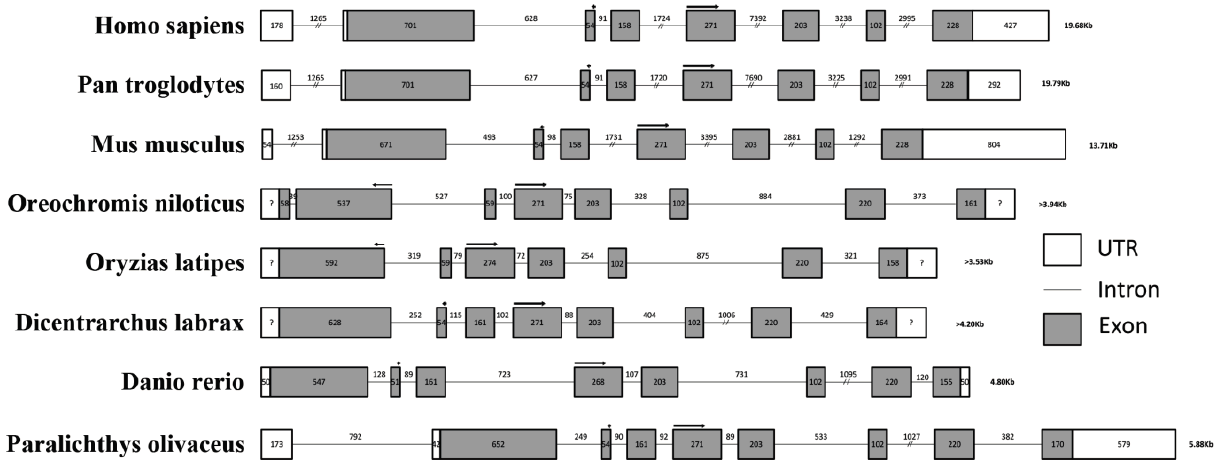
Figure 2. Gene structure analysis of prdm14 . Comparison of the genomic organization of the prdm14 gene between fish and mammals. Exons are shown in shaded boxes, and introns are underlined. The sizes of the primary transcripts and each section are indicated. The 5' and 3' UTRs are enclosed in boxes indicating their respective sizes. The length of the UTRs of Oreochromis niloticus , Oryzias latipes , and Dicentrarchus labrax are unknown, we use “?” to display the unknown sequences. All SET domain sequences are indicated by